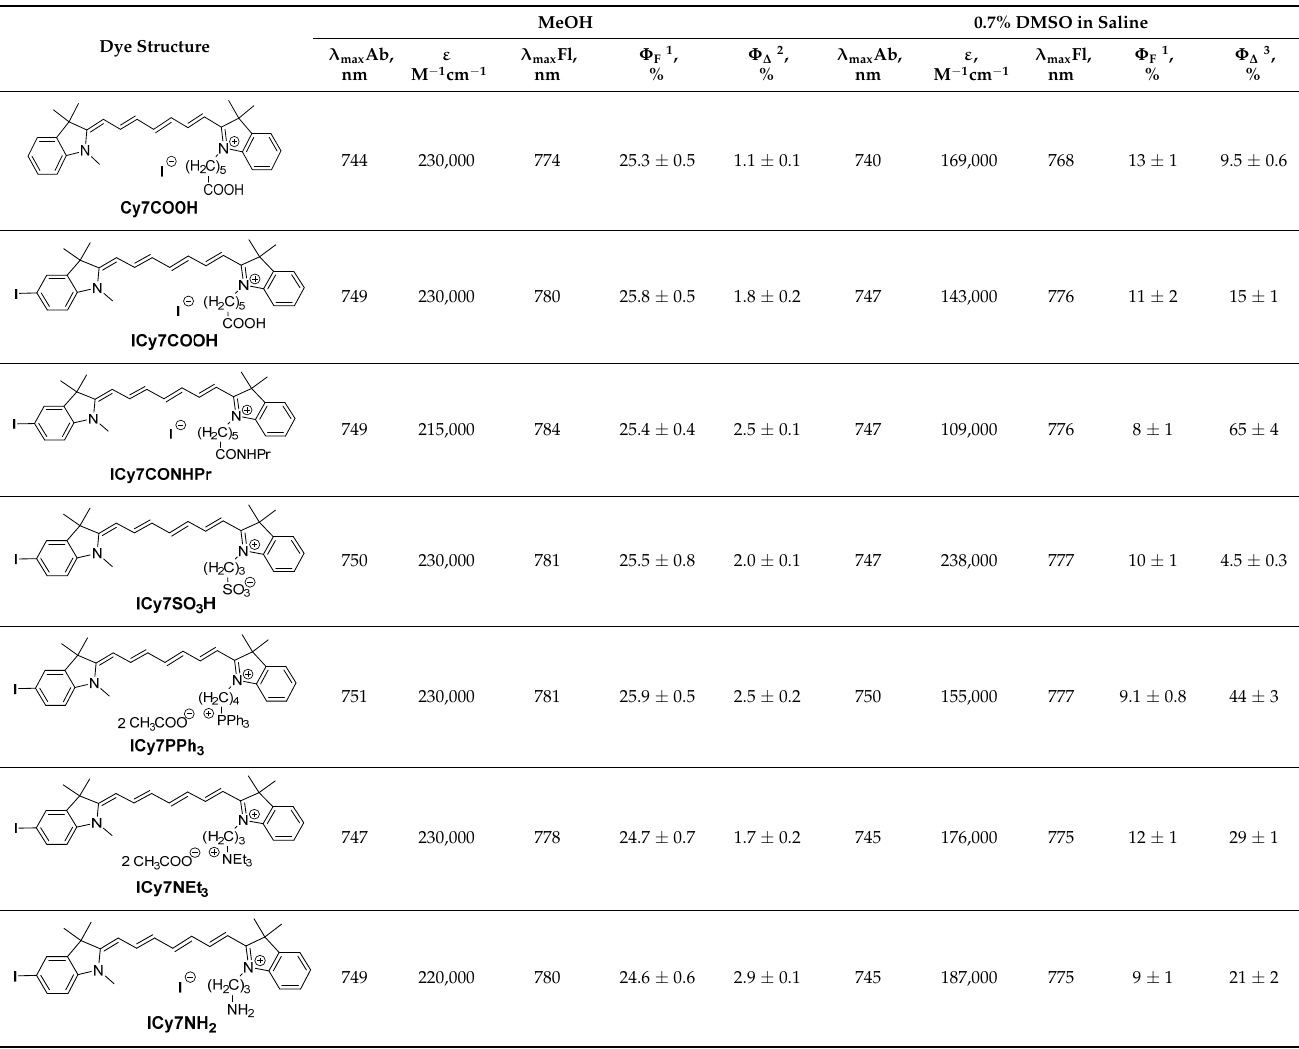
Table 1. Spectral characteristics of the obtained cyanine dyes ( c Dye ~1 µM) measured in methanol and in aqueous saline containing 0.7% DMSO.